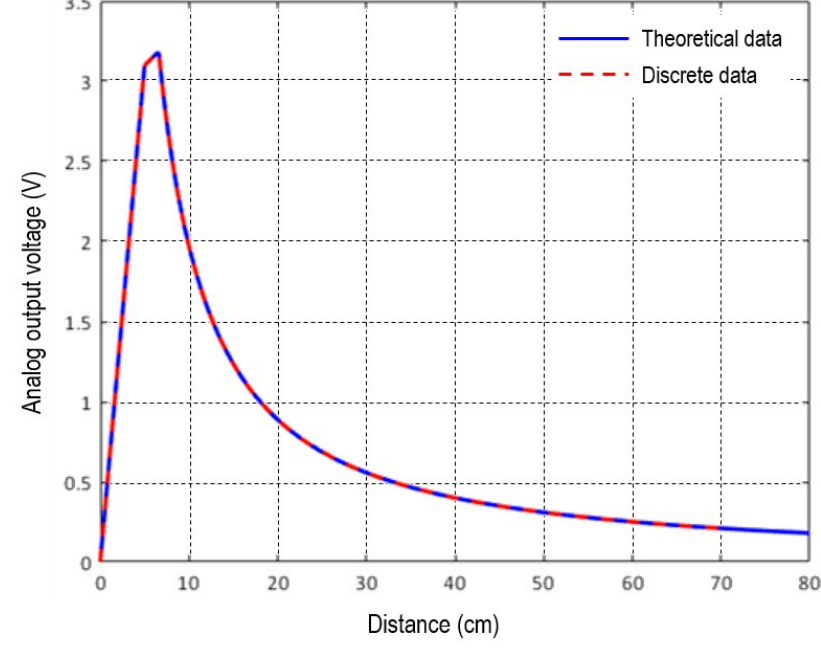
Figure 3. Datasheet for sharp infrared sensor (analog output voltage vs. distance to reflective